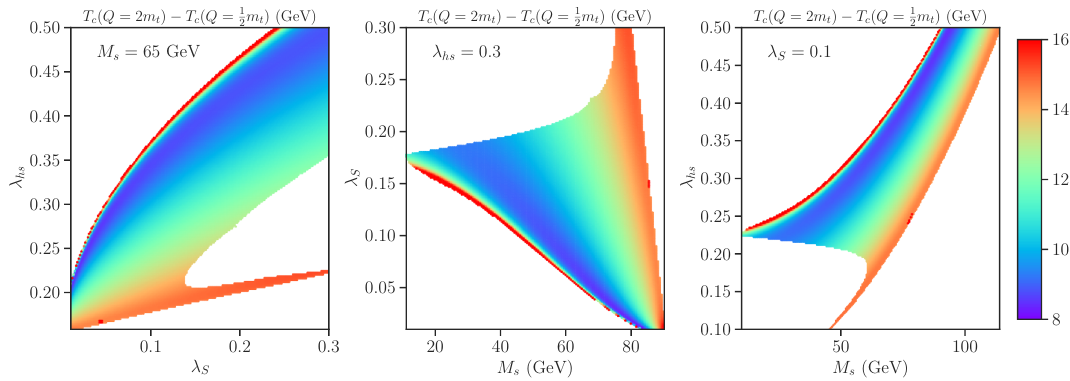
Figure 9 . The renormalisation scale dependence in the MS scheme for the critical temperature T c found by varying the renormalisation scale from Q = 1 blank regions there are no points with a FOPT at both Q = 1 in the left panel, λ = 0 . 3 in the middle panel, and λ hs